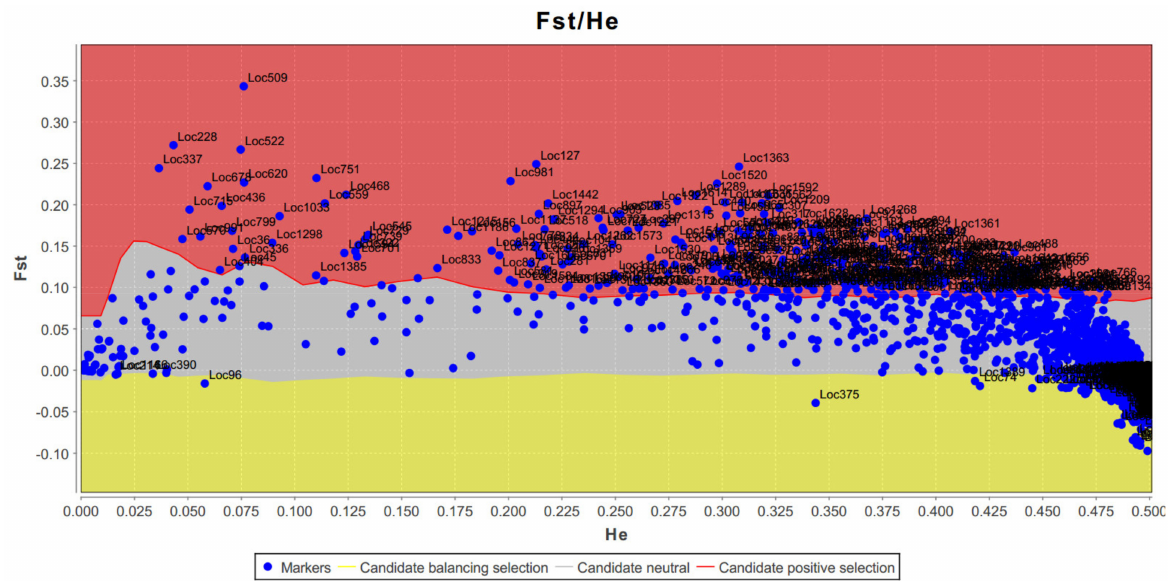
Figure 1. Identification of outlier loci for neutral Fst, performed in the LOSITAN software using the set of 1667 SNP loci analyzed in 553 E. oleifera plants from 206 half-sibling families, which make up for a group of 19 populations sampled in six major geographic regions of the Brazilian Amazon